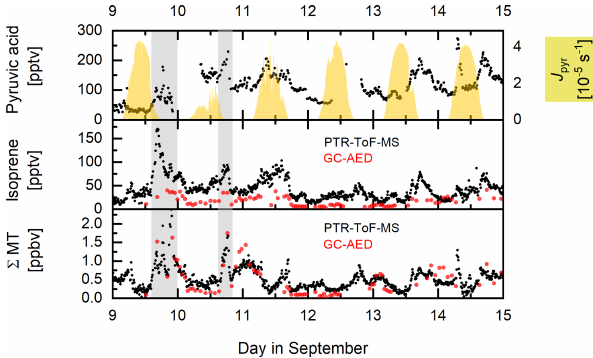
Figure 2. Times series of pyruvic acid, isoprene and total monoter- penes ( (cid:54) MT). The shaded areas represent periods where the site was impacted by sawmill activity.